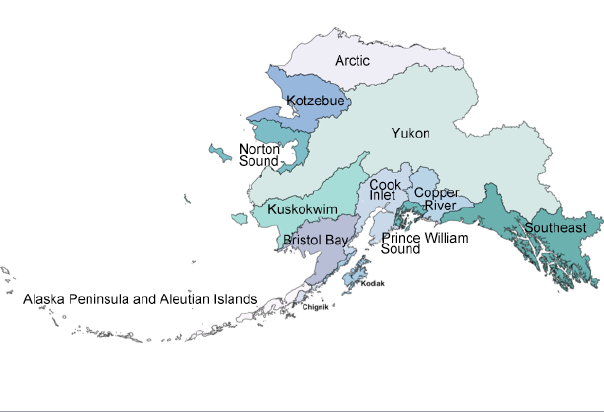
Fig. 1. Map of the regions used for the State of Alaska Salmon and People